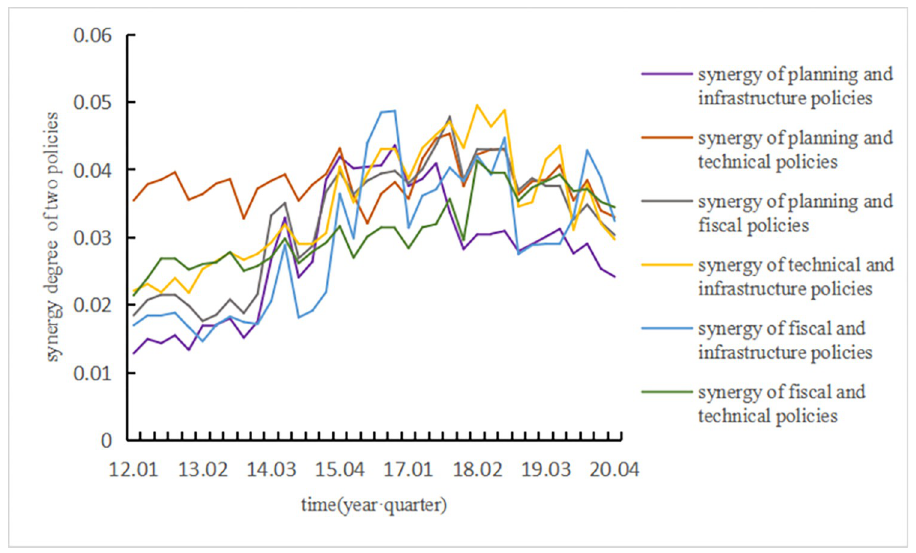
Fig 3. Policy synergy in each quarter from 2012 to 2020.